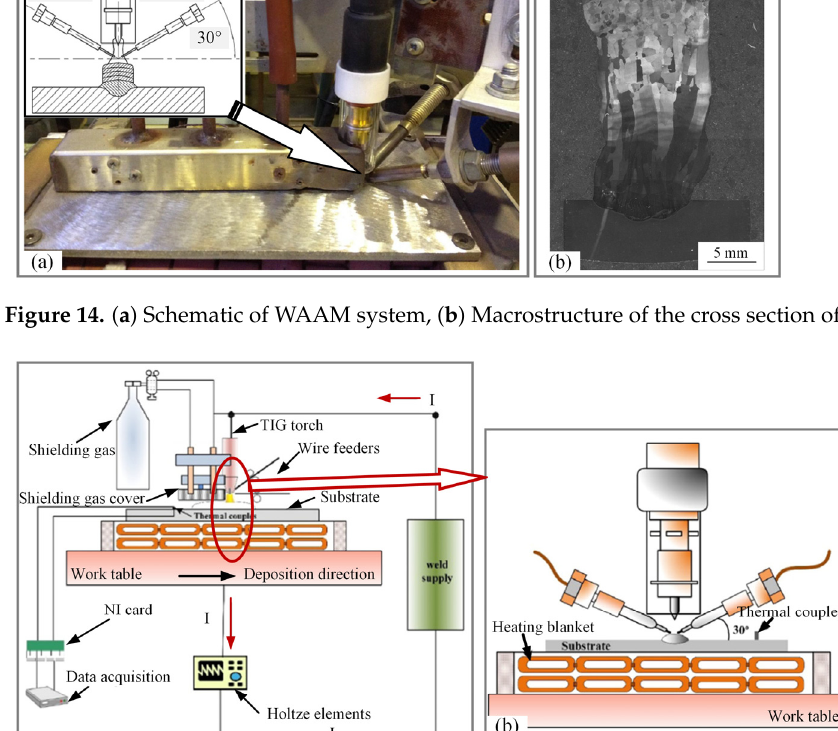
Figure 16. Microstructure with progressively higher Al content from the bottom to the top [72]. Figure 17. Schematic of WLAAM [77]. Gradient component type. Dharmendra et al. [78] fabricated gradient-component FGMs with a gradient from 316L stainless steel to nickel–aluminium bronze (NAB) by